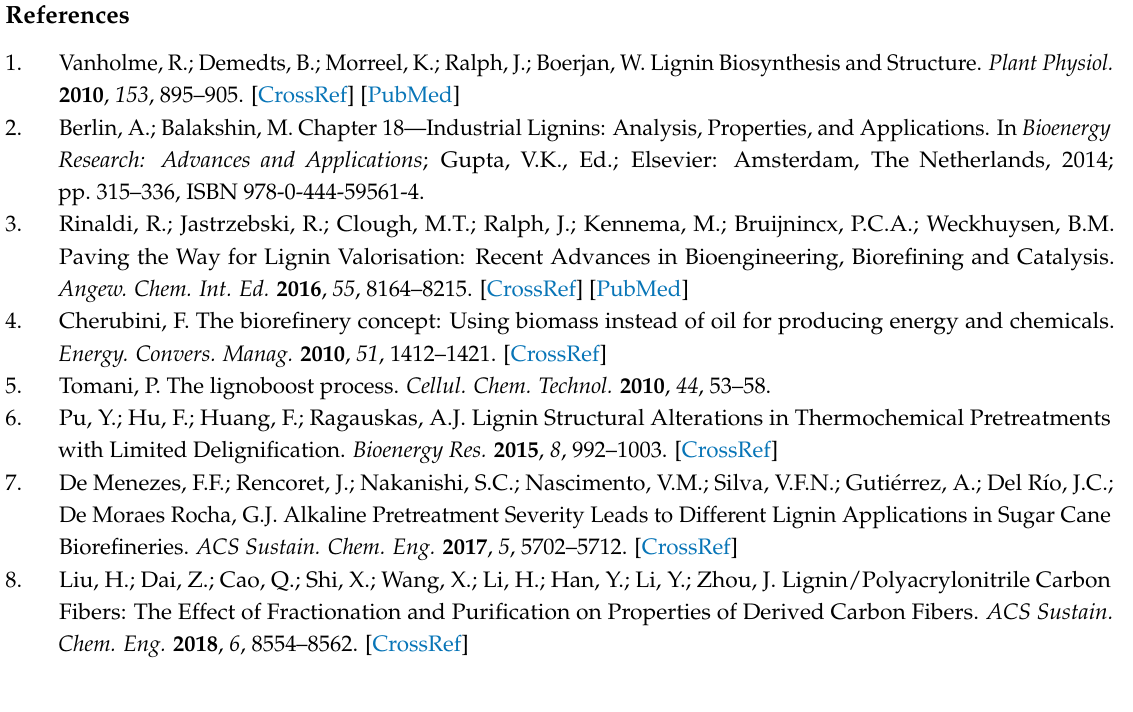
Figure S2: HSQC of acetylated pine lignin, Figure S3: HSQC of acetylated spruce lignin, Figure S4: HSQC of partially methylated birch lignin, Figure S5: HSQC of partially methylated pine lignin, Figure S6: HSQC of partially methylated spruce lignin, Figure S7: HSQC of fully methylated pine lignin, Figure S8: 31 P-NMR of the BLN softwood lignin and MWL, Figure S9: 31 P-NMR of the partially methylated BLN lignin, Figure S10: 31 P-NMR of the fully methylated BLN pine lignin, Figure S11: 31 P-NMR of the acetylated BLN lignin, Figure S12: 31 P-NMR of the softwood lignin fractions besides the BLN lignin (MTBE insoluble), Figure S13: 13 C-NMR of pine BLN and MWL, Figure S14: 13 C-NMR of spruce BLN and MWL, Figure S15: 13 C-NMR of acetylated spruce and pine BLN lignin, Figure S16: TGA of unmodified pine lignin and acetylated pine